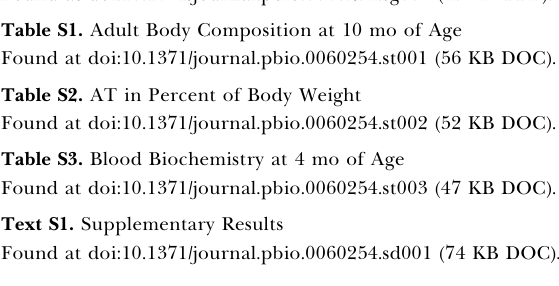
Figure S5. Short-Term Survival of 3-Mo-old bIGF1RKO þ / (cid:2) Mice Challenged with Oxidative Stress bIGF1RKO þ / (cid:2) and Control Males